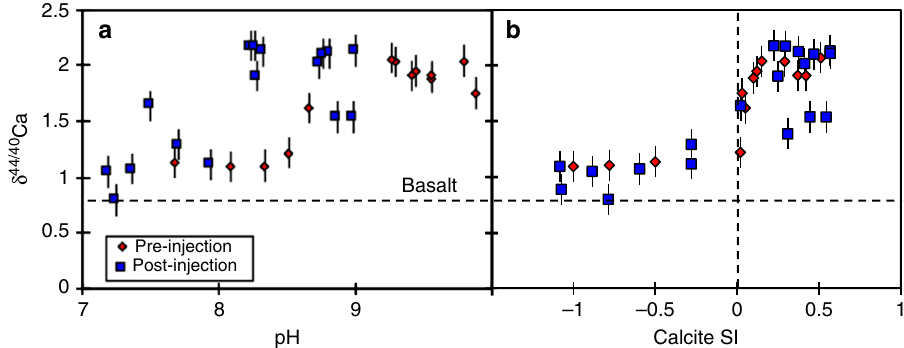
Fig. 2 Relationship between Ca isotopes and groundwater pH and calcite saturation indices. a Ca isotope ratios plotted against water pH; b and against the calcite saturation index. Both plots show that Ca isotope ratios increase as the conditions for calcite precipitation improve. Pre-injection waters are the red diamonds, and post-injection waters the blue squares. The horizontal dashed black line represents the Ca isotope ratio of basalt, while the vertical dashed black line represents saturation (SI = 0). The error bars represent 2 s.e. internal analytical uncertainty NATURE COMMUNICATIONS| (2019) 10:1983